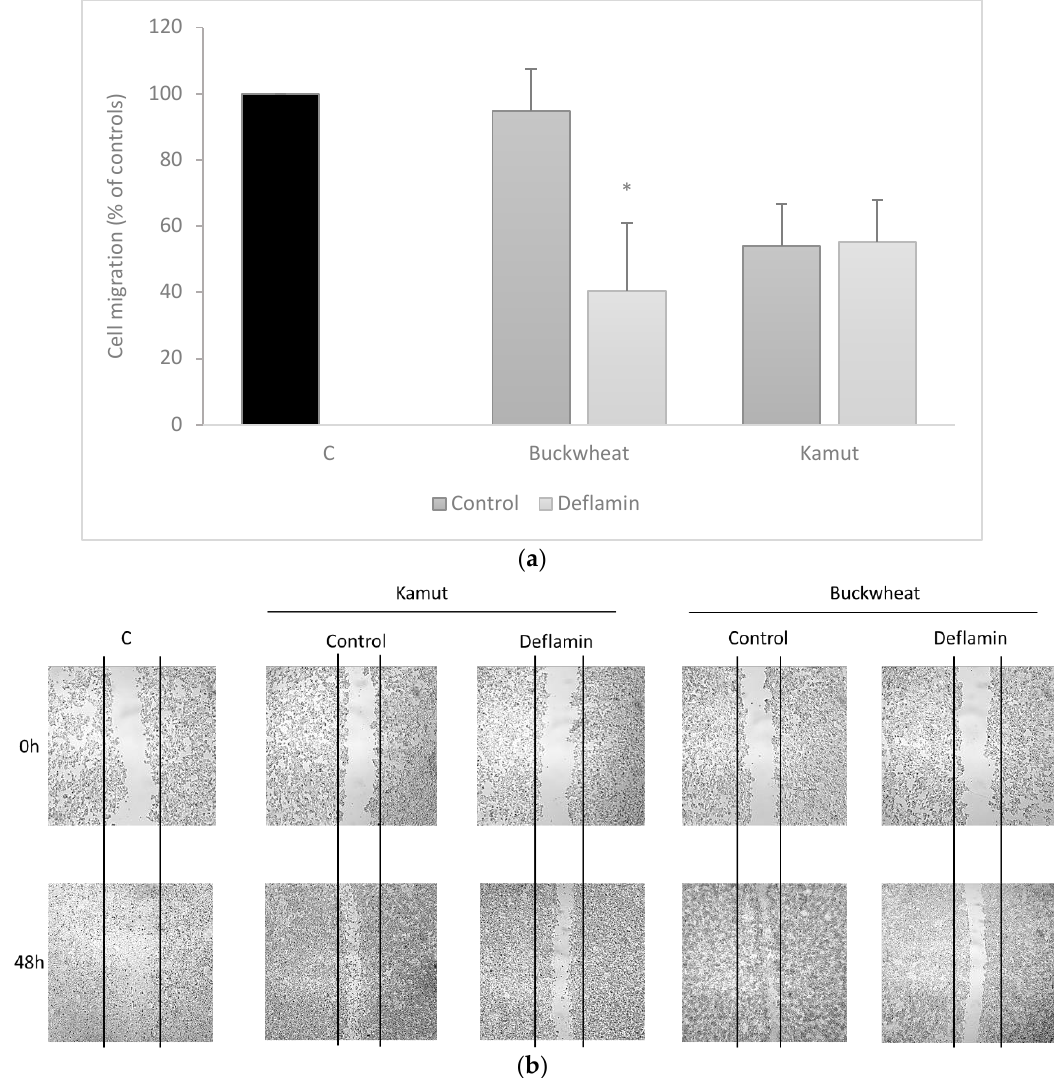
Figure 6. HT29 cell migration after exposure to cookies as determined by the wound healing assays: ( a ) Relative migration rates. Values are the averages of three replicate tests ± SD and are expressed as percentages of wound closure in relation to 0 h. Note: * represents p < 0.05 when compared to controls. ( b ) Representative images of cell migration demonstrating the inhibitory effects of kamut and buckwheat cookies. Cells were exposed to 100 µ g protein.mL − 1